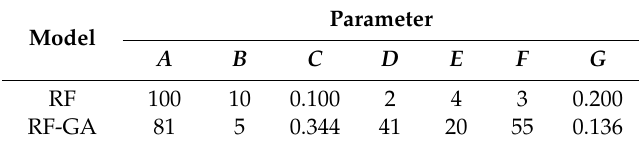
Table 8. Parameters of the RF and RF-GA models.